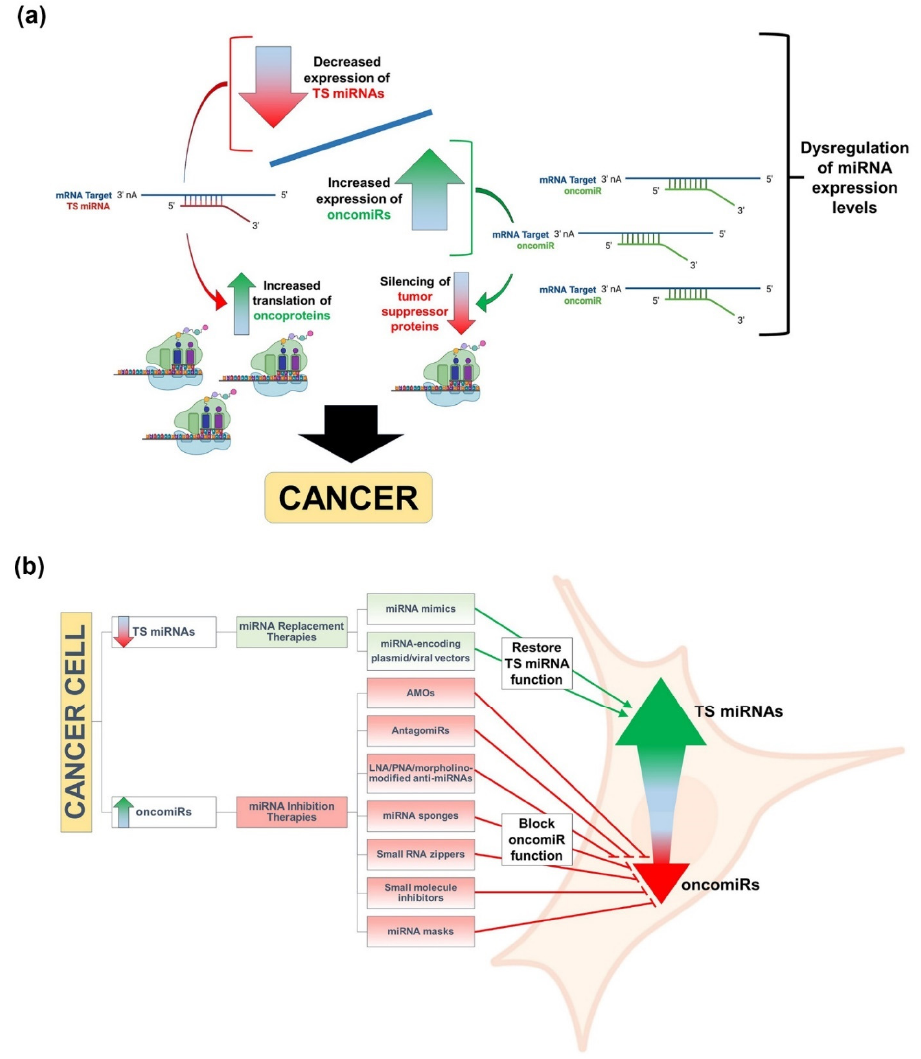
Figure 1. Graphical depictions highlighting the different types of cancer-associated miRNAs and the molecular therapeutic approaches to alleviating their abnormal expression in cancer. ( a ) Classes of tumor-associated miRNAs and their mechanisms of promoting cancer. Tumor-associated miRNAs are classified as either oncogenic miRNAs (oncomiRs) or tumor suppressor miRNAs (TS miRNAs), and the dysregulation of the expression levels of these tumor-associated miRNAs leads to cancer onset and progression. In particular, oncomiRs are typically overexpressed in malignant cells/tissues and promote cancer by silencing mRNAs encoding tumor suppressor proteins (green curved arrow), whereas TS miRNAs are downregulated and result in increases in the translation of their target oncoprotein-encoding mRNAs (red curved arrow). ( b ) miRNA inhibition and replacement therapies for cancer treatment. miRNA inhibition and replacement therapies are molecular interventions designed to either suppress oncomiR or restore TS miRNA functions, respectively. Approaches to enhance TS miRNA function via miRNA replacement therapy have been achieved through the use of chemically synthesized/modified, double-stranded miRNA mimics, as well as through the use of plasmid or viral vectors engineered to encode specific TS miRNAs that can replenish the lost miRNAs within cancer cells. Alternatively, approaches to antagonize oncomiR function via the use of antimiRs, resulting in the impairment of cancer progression, have been achieved through the use of antisense miRNA oligonucleotides (AMOs), antagomiRs, locked nucleic acid (LNA)/peptide nucleic acid (PNA)/morpholino-modified anti-miRNAs, miRNA sponges, small RNA zippers, small-molecule inhibitors, or miRNA masks. Select images within the figure were acquired from